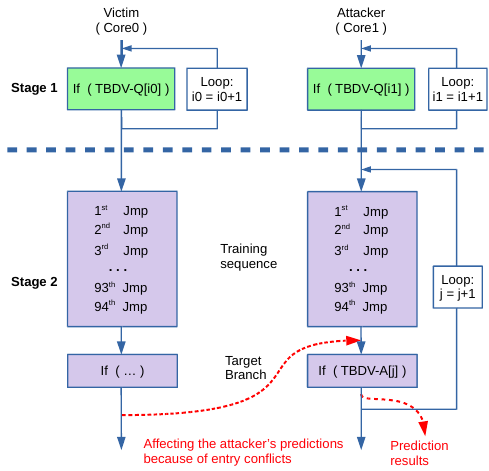
Figure 3: Overview of the Bluethunder attack. The two stages are “Activating the 2-level predictor” and “Leaking Secrets”